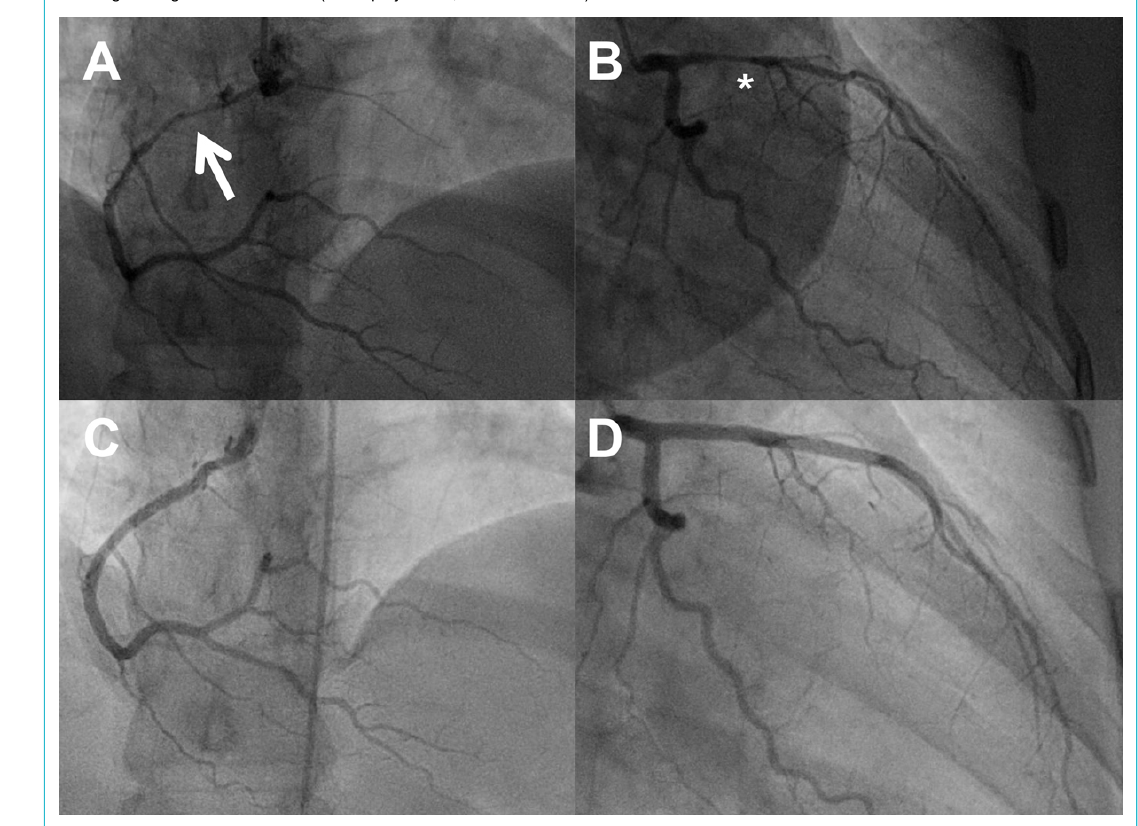
Figure 3: Serial angiograms of a 41-year-old woman (postpartum) with spontaneous coronary artery dissection (SCAD) of the right coronary artery (RCA; panel A, cranial view, arrow pointing to the dissection) and SCAD of the left anterior descending artery (LAD) eight days later (panel B, right anterior oblique 30°/caudal 20° view, asterisk highlighting the dissection). Panels C and D: repeat angiogram after 6 months showing healing of the dissections (same projections; see also Table